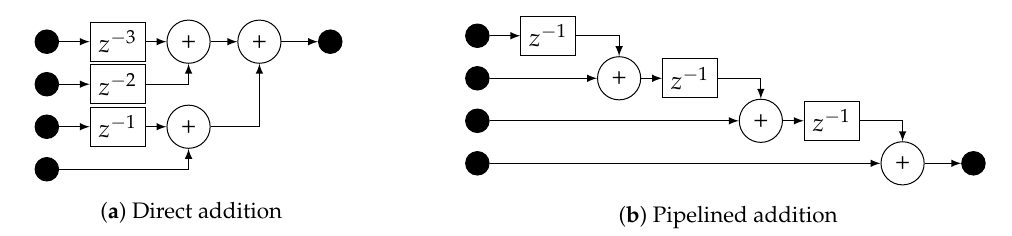
Figure 7. Comparison of triangular register methods. ©IEEE. Reprinted, with permission, from [9].